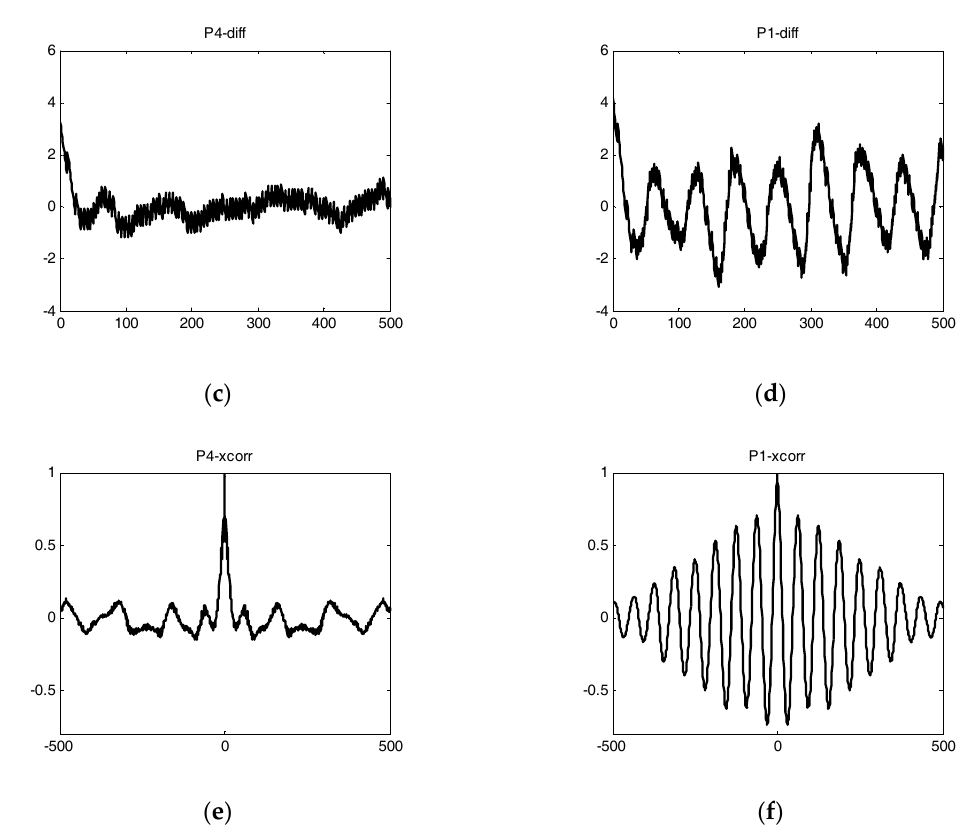
Figure 9. In this figure, ( a ) and ( b ) are the framework of the maximum domain and its linear tendency of P4 and P1. ( c ) and ( d ) are the f n of P4 and P1. ( e ) and ( f ) are the c ( m ) of the two waveforms. We present two new features which are bound up c ( m ) , that is, ˆ a s and ˆ N m . They are used to distinguish P1 from